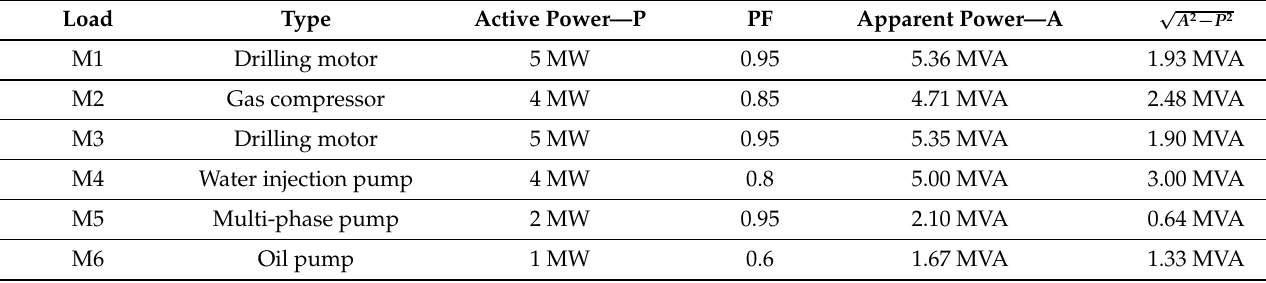
Figure 7. Simulink block diagram for Case 3. Table 1. Parameters of the loads of Figure 1.